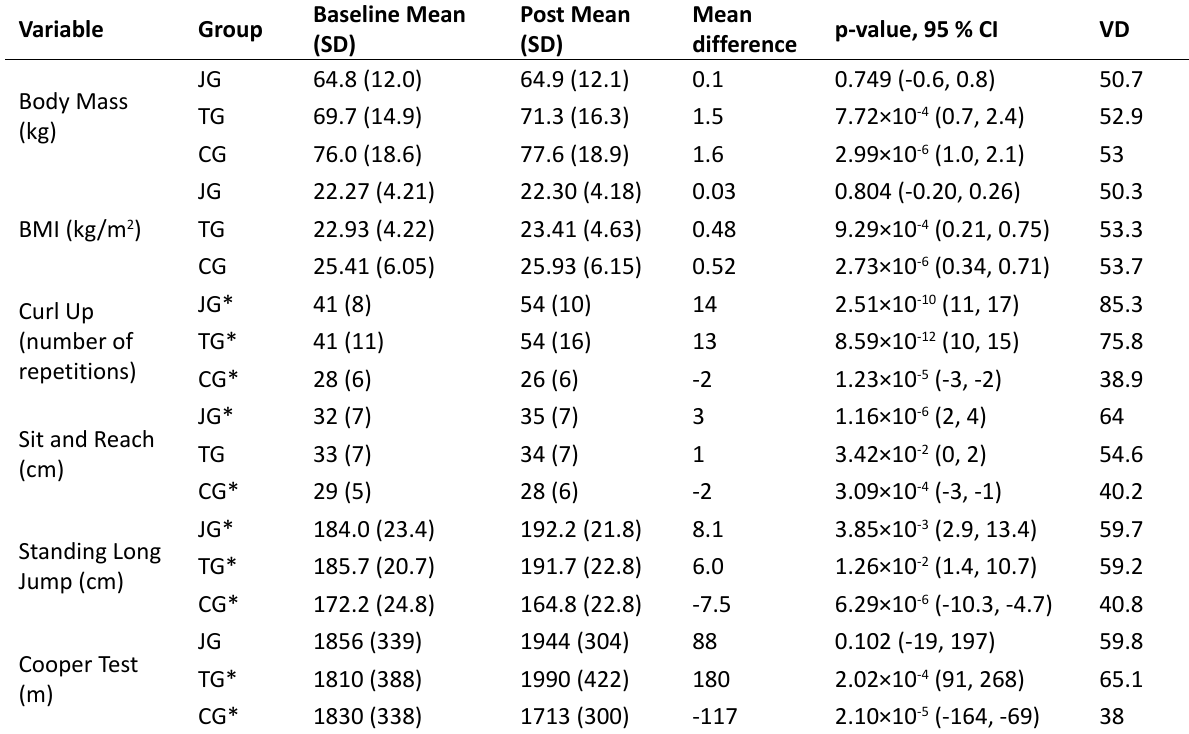
Table 2. Baseline vs post